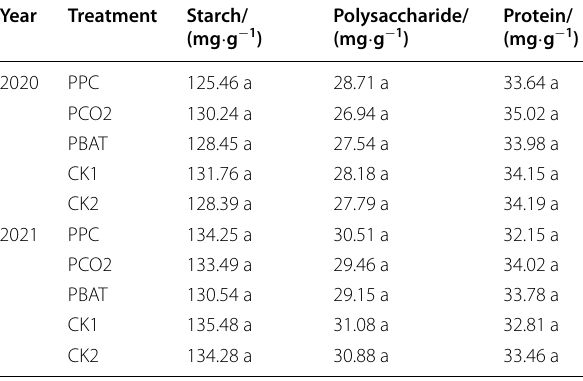
Table 3 Analysis of quality indexes of Taro with different treatments